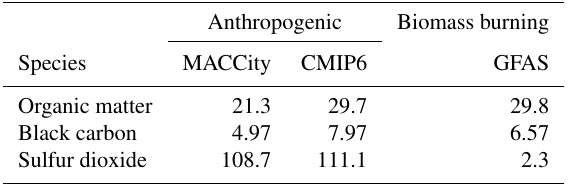
Table 4. Global emissions in 2014 of organic matter, black carbon, and sulfur dioxide (Tgyr − 1 ). Anthropogenic (non-biomass burn- ing) sources from MACCity and CMIP6 as well as biomass burning sources from GFAS are